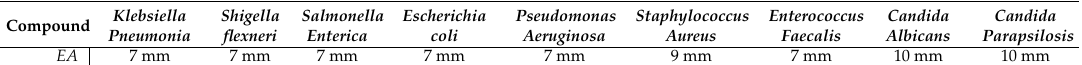
Table 3. The inhibition diameters for selected strains after incubation with 30 µ g/ml of EA. Klebsiella Compound